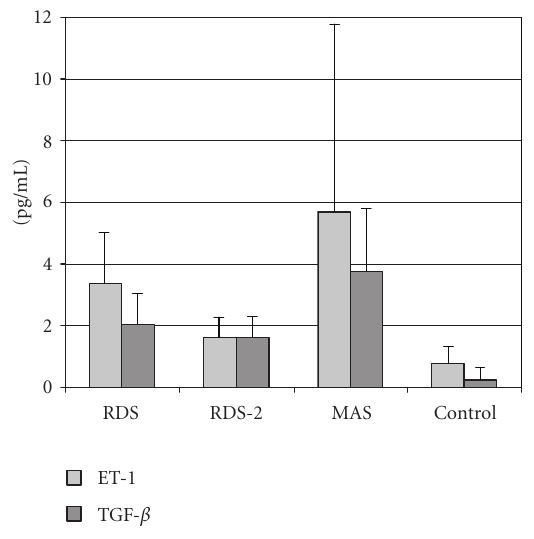
Figure 2: ET-1 concentrations according to diagnosis in the sick newborns at the sixth hour after birth were 3 . 37 ± 1 . 59pg/mL in RDS, 1 . 60 ± 0 . 66pg/mL in RDS-2, 5 . 70 ± 5 . 87pg/mL in MAS, and 0 . 78 ± 0 . 50pg/mL in healthy group. Only the concentrations of ET- 1 in RDS and MAS groups were significantly di ff erent ( P < . 05). Also plasma TGF- β concentrations were 2 . 05 ± 0 . 98pg/mL in RDS, 1 . 59 ± 0 . 66pg/mL in RDS-2, 3 . 75 ± 1 . 94pg/mL in MAS and 0 . 22 ± 0 . 39pg/mL in healthy group. Only the di ff erence in RDS and MAS group was significant ( P < . 05).